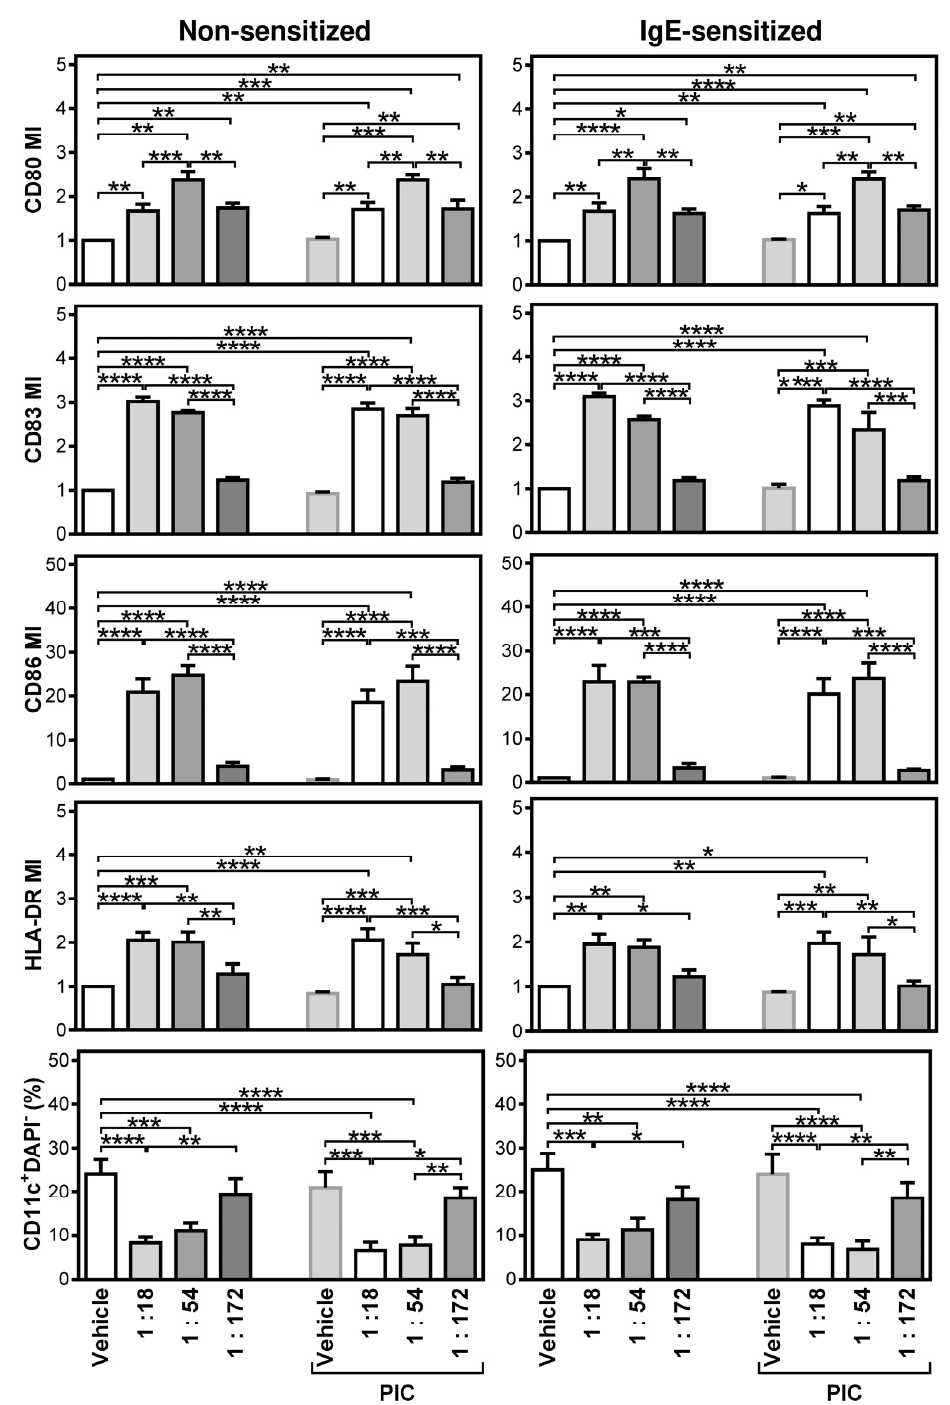
Figure 5. Evaluations of the impact of thapsigargin-stimulated LAD2 MCs and poly I:C on the maturation of monocyte- derived DCs produced in the serum-free medium. Monocyte-derived immature(i)DCs were produced in the serum-free medium and matured for 20–24 h in F-bottom 96-well plate wells (0.2 × 10 6 of iDCs in 200 µ L of culture medium) in the presence or absence of poly I:C (PIC, 25 µ g/mL) by no co-culture (Vehicle) or co-culture with thapsigargin-stimulated LAD2 MCs at a ratio 1:18, 1:54, or 1:172 (LAD2 MCs:iDCs). The matured DCs were stained with the fluorescently labeled antibodies specific to the selected maturation markers and analyzed by flow cytometry as in Figure 2. The maturation indexes of DCs (MIs) for individual markers and the proportions of viable DCs (DAPI-CD11c+) were evaluated. Bars represent the mean of values and SEM determined in each group. The significance of differences among the group of cells is indicated (* p < 0.05, ** p < 0.01, *** p < 0.001, **** p < 0.0001; n = 6 donors, 1-way ANOVA with the Tukey